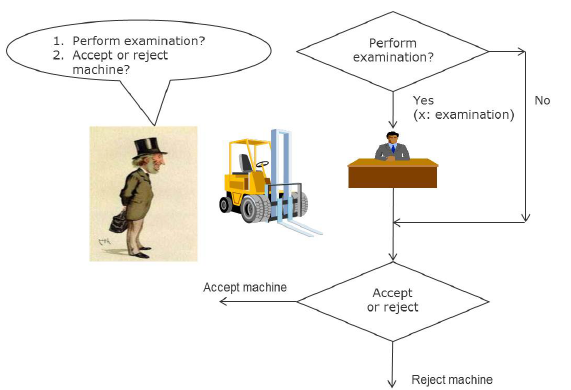
Figure 3: The buyer of the forklift may examine the forklift before accepting or rejecting